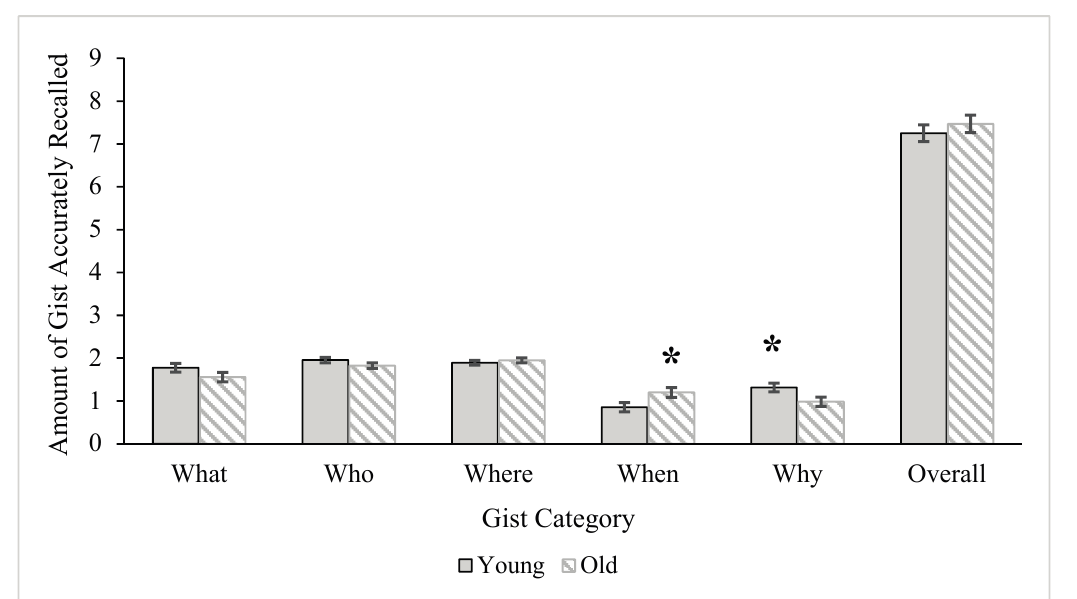
Figure 1. Age group differences for overall gist accuracy and accuracy of gist categories. Error bars represent ± 1SE. Asterisks mark significant effects at the p < 0.05 level. Age differences are no longer significant after including covariates (episodic memory, education) in the